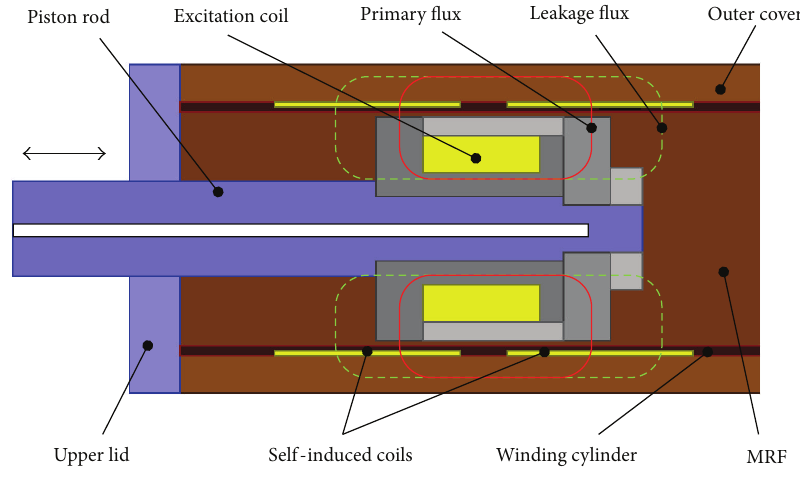
Figure 3: Principle diagram of DDSMRD.